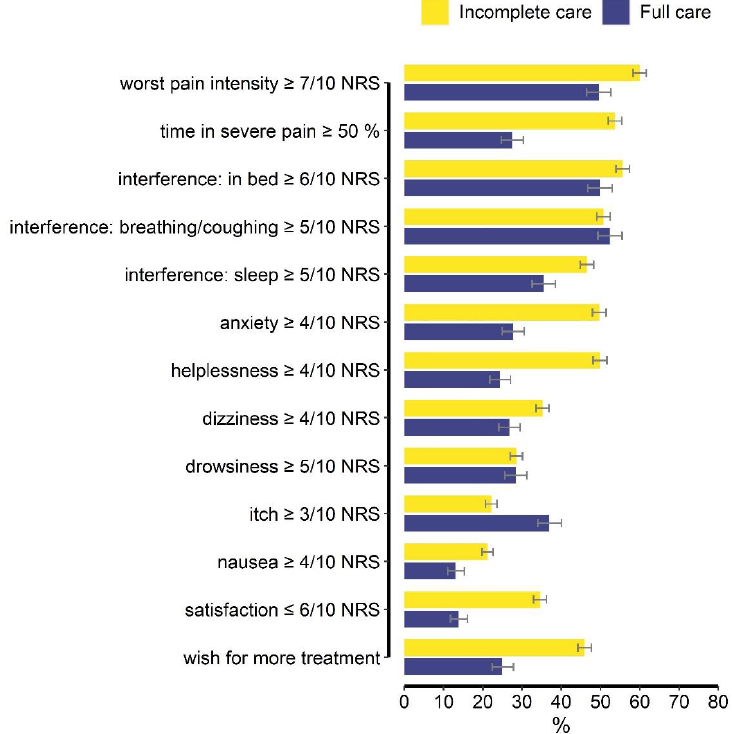
Figure 2. Presents a summary of dichotomized patient-reported outcome measures that form the Pain Composite Score and two additional outcomes. Results are shown separately for women who received “full” care (blue bars) compared to “incomplete” care (yellow bars). The capped lines indicate the 95% confidence intervals. ‘Satisfaction with results of pain care’ and ‘Would have liked more pain treatment ’ are not part of the Pain Composite Score but are included here to provide additional information about women’s responses to the surgery and treatment .